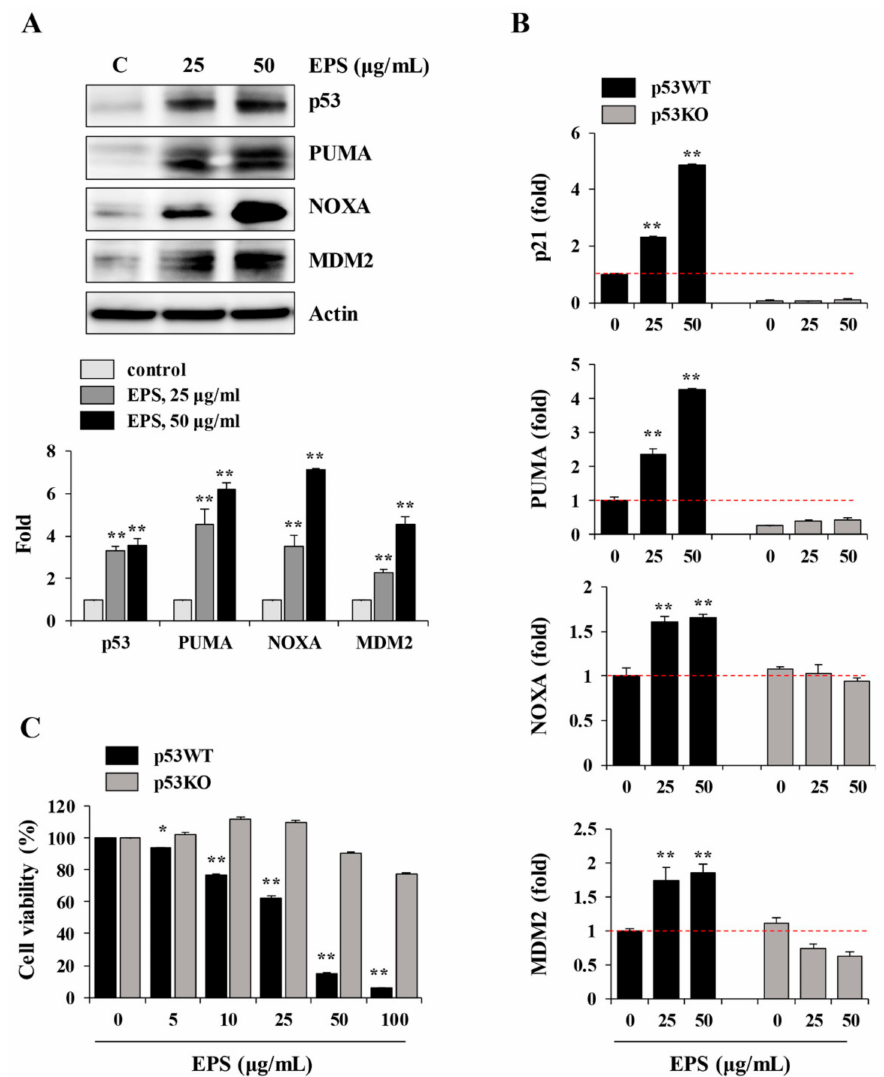
Figure 5. EPS induces p53-dependent apoptosis in hiPSCs. ( A ) hiPSCs treated with EPS (25 and 50 µ g / mL) for 24 h were subjected to Western blotting. The levels of p53, PUMA, NOXA, and MDM2 were determined and the relative band intensities compared with EPS-untreated control hiPSCs were calculated using Image J software. ( B ) After treating p53 wild-type (p53WT) and p53 knockout (p53KO) hiPSCs with indicated concentrations of EPS for 12 h, the mRNA levels of p53-dependent genes (p21, PUMA, NOXA, and MDM2) were measured by real-time PCR analysis. Data are expressed as the mean ± SD from triplicate samples and represented as fold increases relative to that of EPS-untreated p53WT hiPSCs. ( C ) p53WT and p53KO hiPSCs were seeded on 24-well culture plates and treated with the indicated concentrations of EPS for 24 h. Cell viability was measured using the CCK-8 and relative cell viability compared with EPS-untreated control hiPSCs was calculated. Data are expressed as the mean ± SD from triplicate samples. * p < 0.05 and ** p < 0.01 vs. EPS-untreated